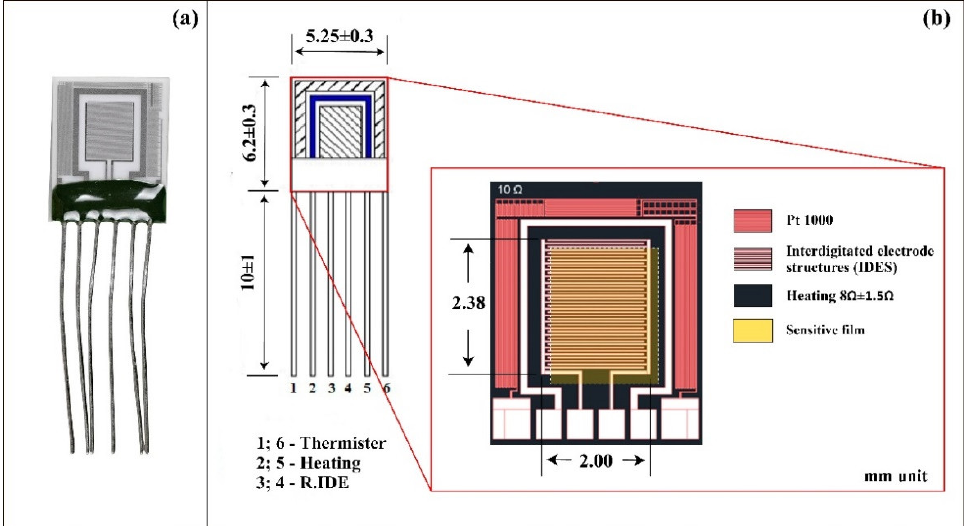
Figure 3. ( a ) Actual photo and ( b ) schematic illustration of the gas sensor.